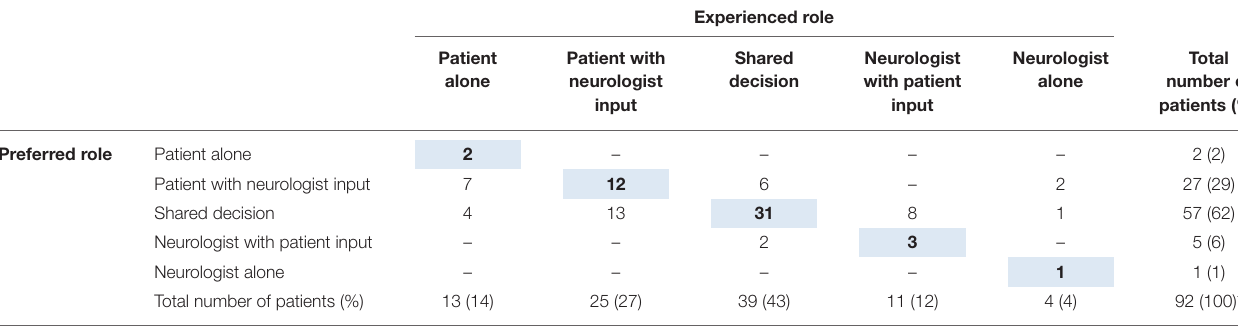
TABLE 2 | Congruency between preferred and experienced roles in decision-making.